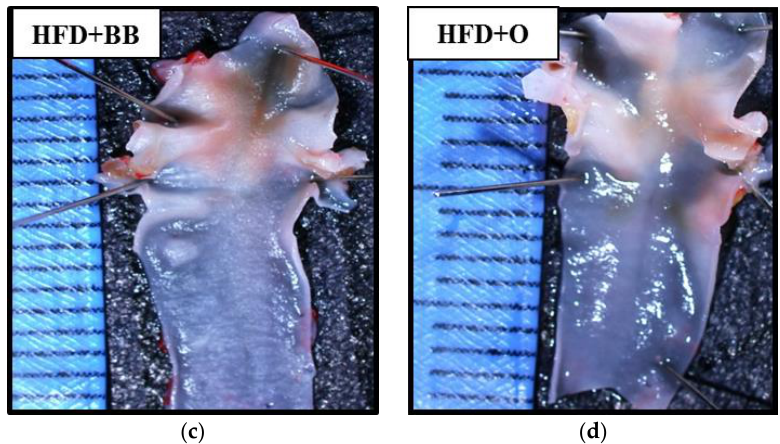
Figure 1. Macroscopic findings of aortic arch segment in Oil Red O staining under a stereomicroscope. Aortic arch segments from N ( a ), HFD + BB ( c ), and HFD + O ( d ) groups show intact aorta arch segments without atherosclerotic plaque. However, the segment from HFD group shows the presence of atherosclerotic plaques (yellow arrow) in the aortic arch ( b ). N, normal; HFD, high fat diet; HFD + BB, high-fat diet and 0.5 g/kg bee bread; HFD + O, high-fat diet and 10 mg/kg orlistat.